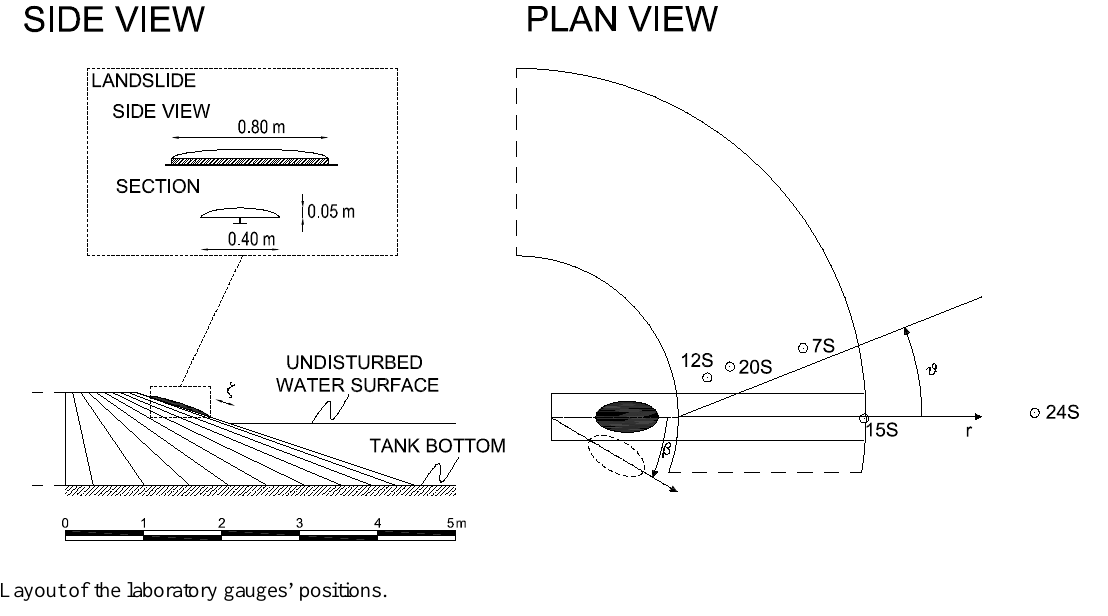
Fig. 3. Layout of the laboratory gauges’ positions.